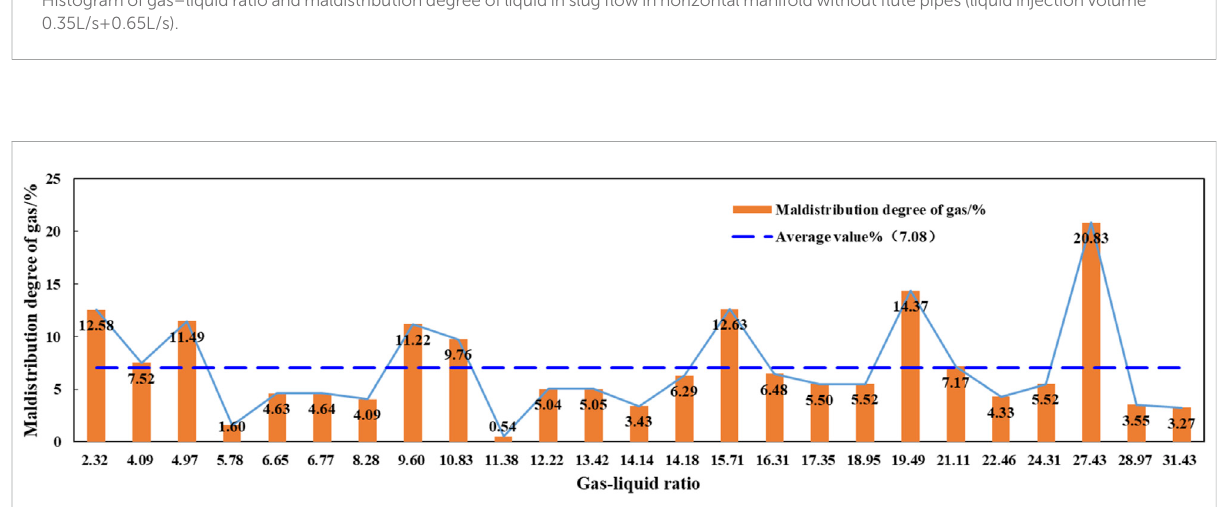
FIGURE 9 Histogram of gas – liquid ratio and maldistribution degree of gas in slug fl ow in horizontal manifold without fl ute pipes (liquid injection volume 0.35L/s+0.65L/s).